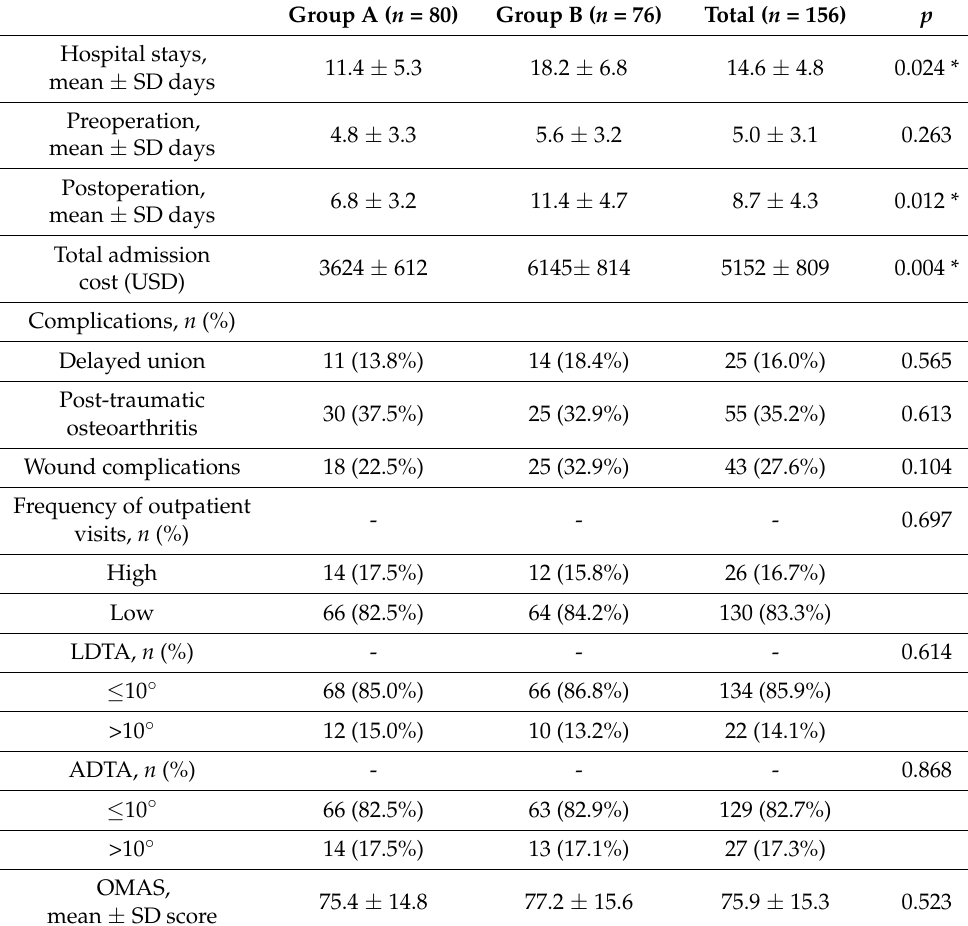
Table 3. The length of hospital stays and the postoperative clinical and radiological outcomes.